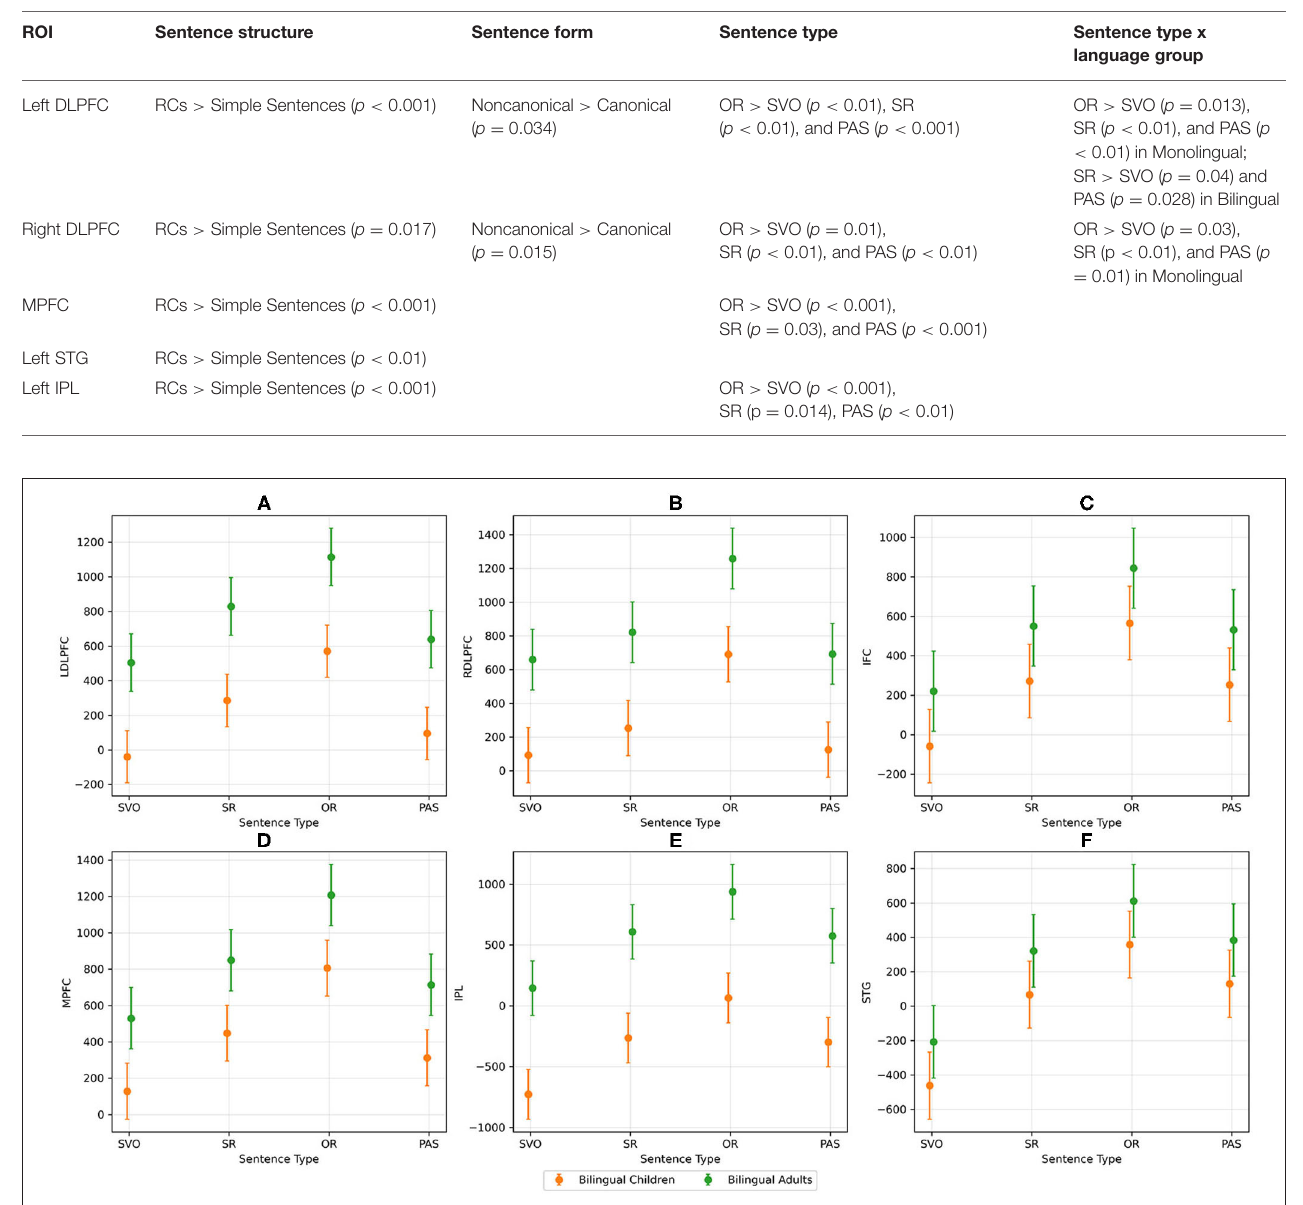
FIGURE 5 | AUC activation for each ROI and sentence type between bilingual children and adults. (A) shows the AUC activation for left DLPFC, (B) shows the AUC activation for right DLPFC, (C) shows the AUC activation for left IFC, (D) shows the AUC activation for MPFC, (E) shows the AUC activation for left IPL, and (F) shows the AUC activation for left